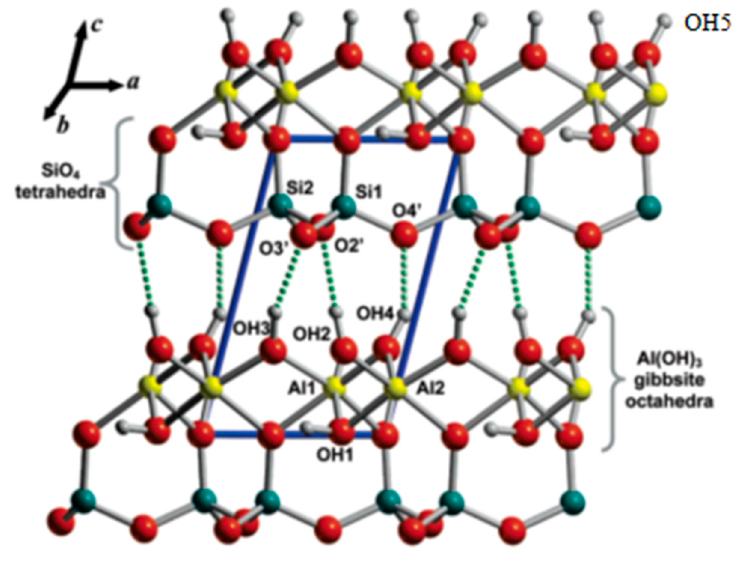
Figure 1. The structure model of kaolinite [7] (OH1, inner OH groups; OH2, OH3, OH4, inner surface OH groups; OH5, outer surface OH groups).